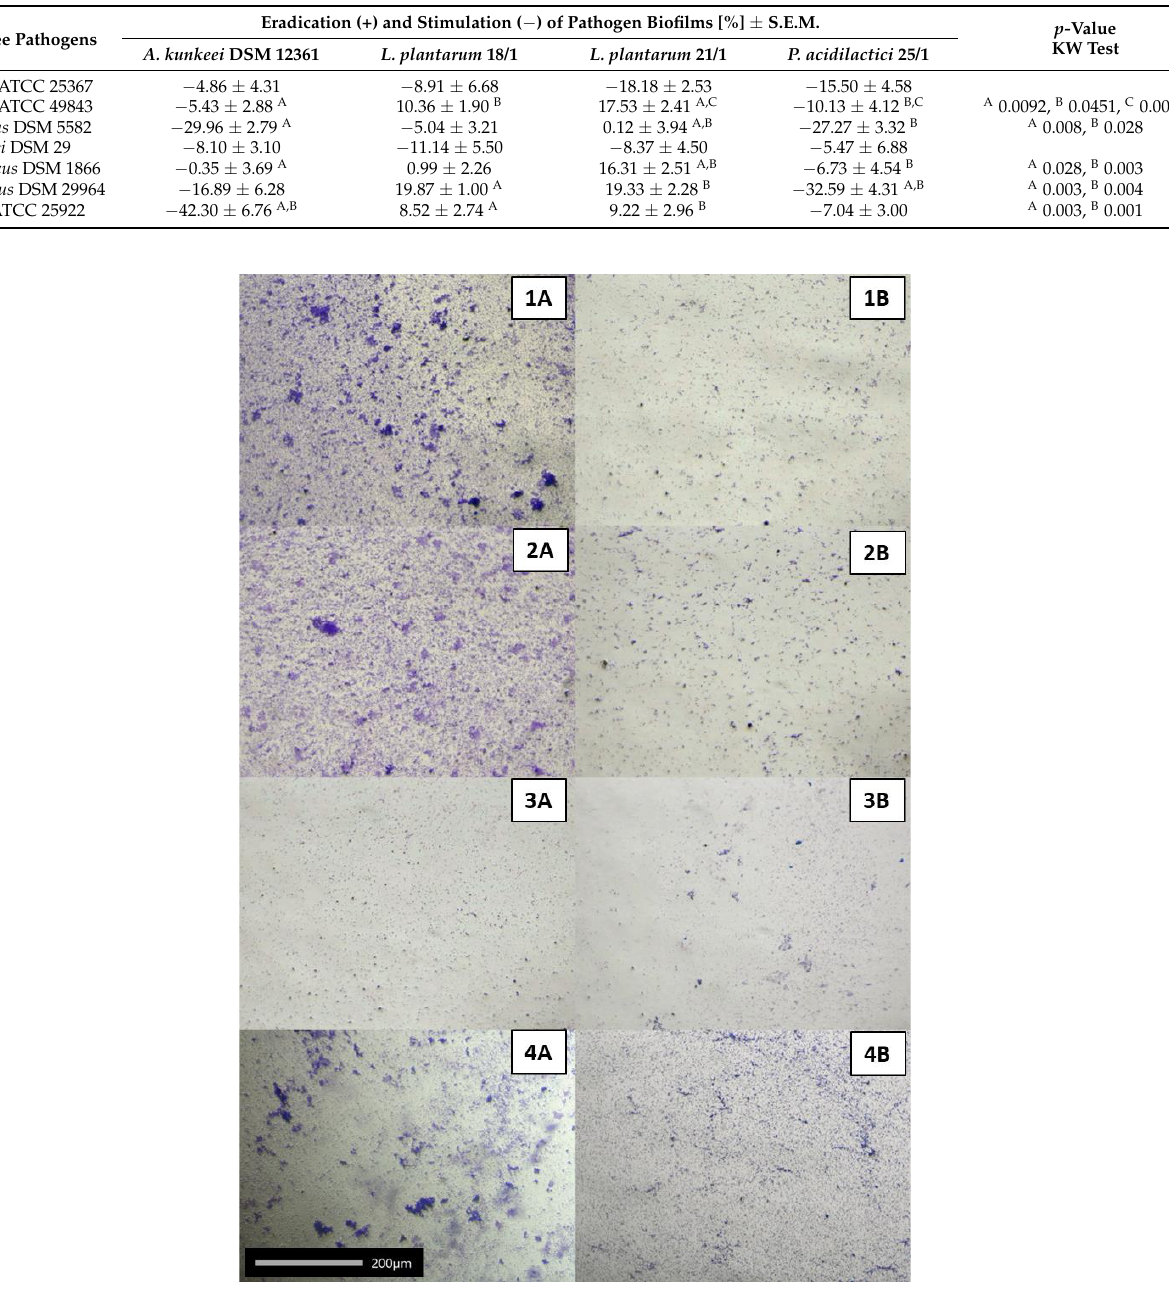
Figure 6. Selected microphotographs showing the effect of cell-free supernatants (CFSs) from L. plantarum 21/1 on biofilm eradication of: 1A P. larvae ATCC 25367; 2A P. larvae ATCC 49843; 3A L. sphaericus DSM 1866; 4A M. plutonius DSM 29964. 1 – 4B : pathogen cells without CFSs (negative con- trols) (objective 20×). Observed under a phase-contrast microscope (Nikon Eclipse Ci H600L, Tokyo,